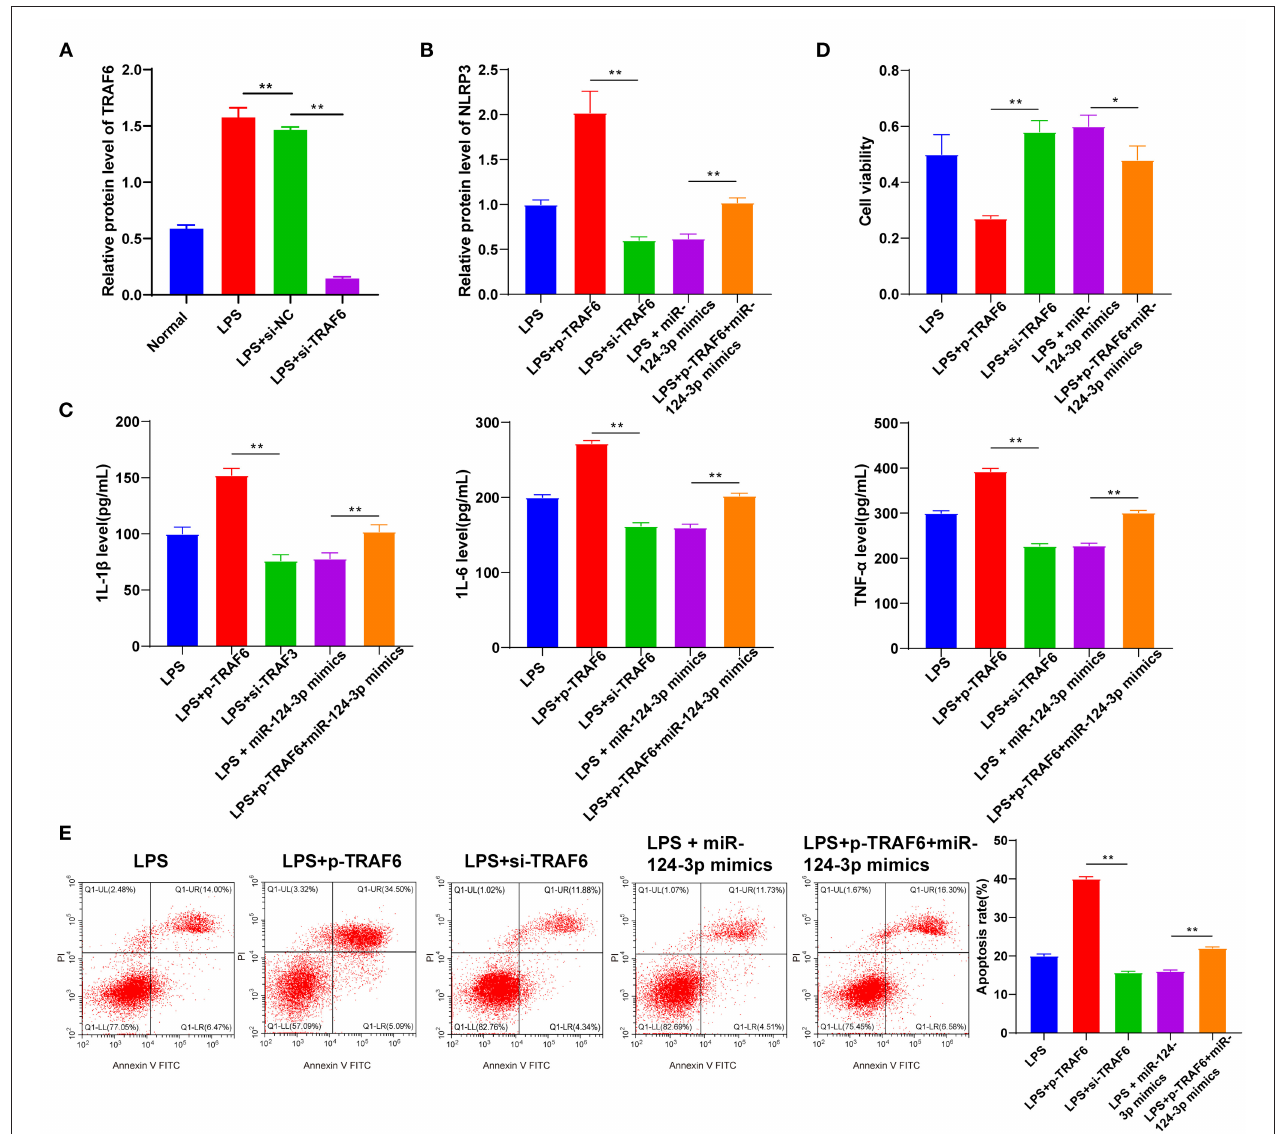
FIGURE 5 | TRAF6 promoted microglial secondary inflammation by mediating the NLRP3 inflammatory pathway. LPS-induced HMC3 cells were transfected with pcDNA3.1, p-TRAF6, si-NC, si-TRAF6, and miR-124-3p mimic. (A) Transfection efficiency of TRAF6 was confirmed using RT-qPCR; (B) The relative expression of NLRP3 was detected using RT-qPCR; (C) The levels of inflammatory factors were detected using ELISA; (D) Cell viability was detected using MTT assay; (E) Cell apoptosis was measured using flow cytometry. The cell experiment was repeated three times independently. Data are expressed as mean ± standard deviation and analyzed using one-way ANOVA, followed by Tukey’s multiple-comparison test, * P < 0.05, ** P <